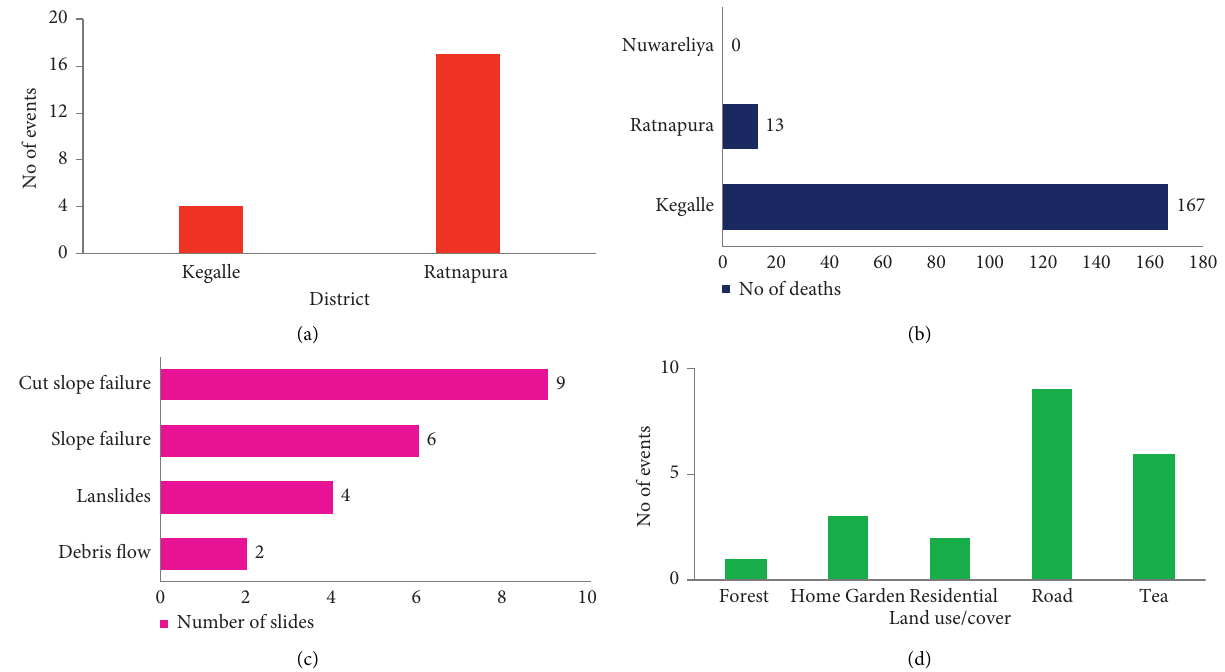
Figure 6: Statistics of landslide distribution in Sabaragamuwa province, Sri